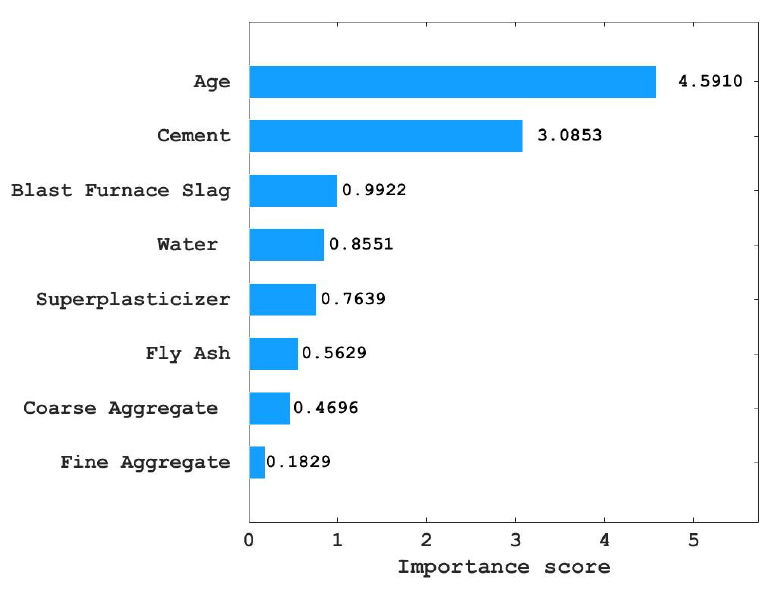
Figure 9. Variable importance of the compressive strength.